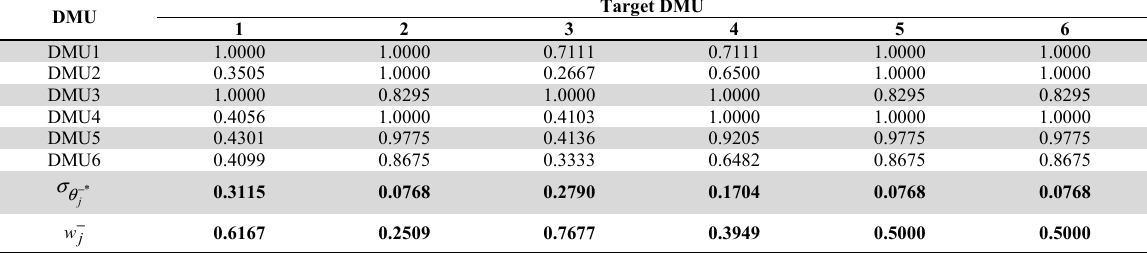
Anti-Ideal CEM of six nursing homes